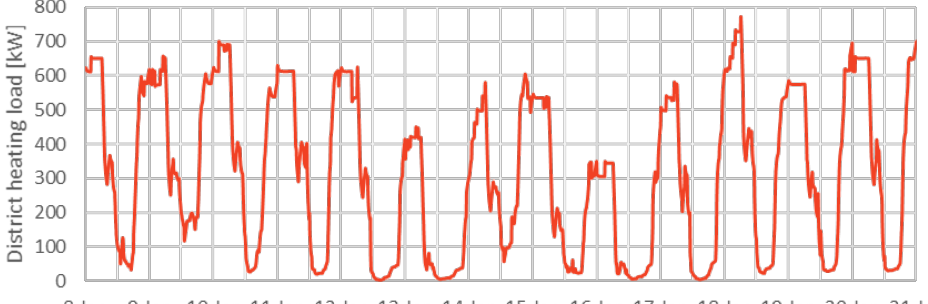
Figure 10. District heating load during a two-week period in January obtained by